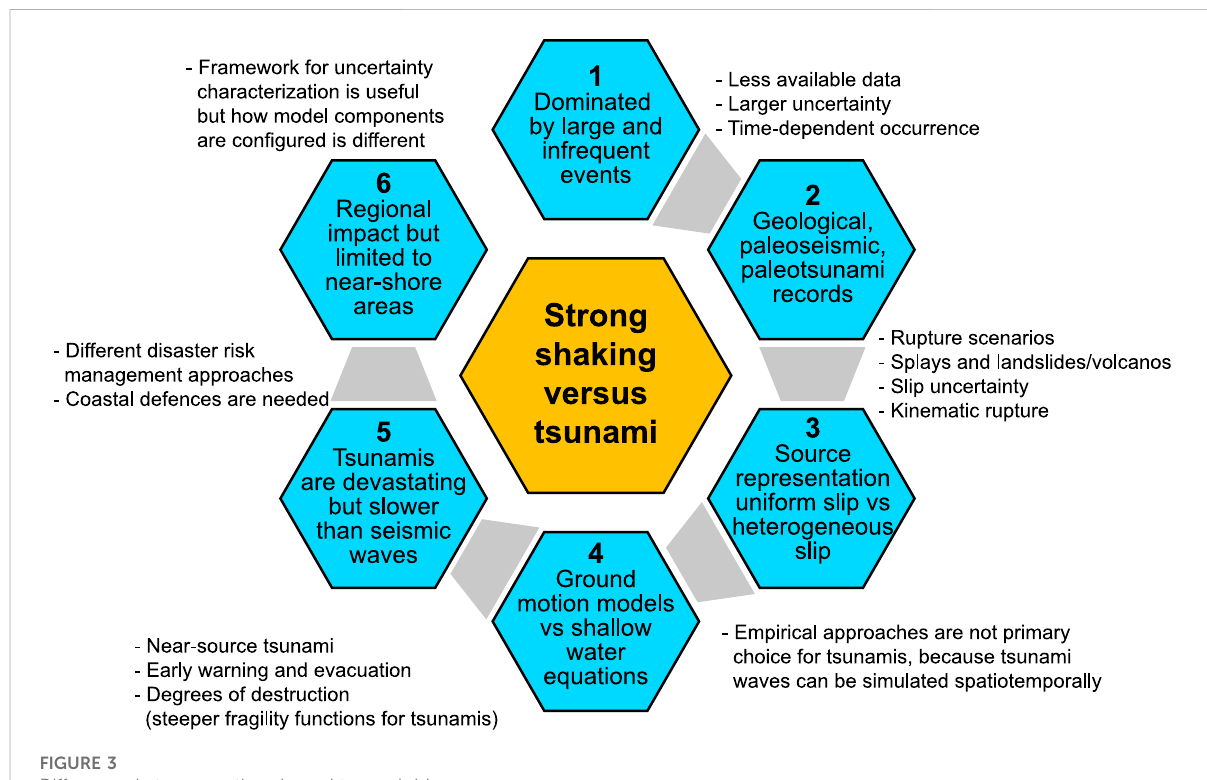
FIGURE 3 Differences between earthquake and tsunami